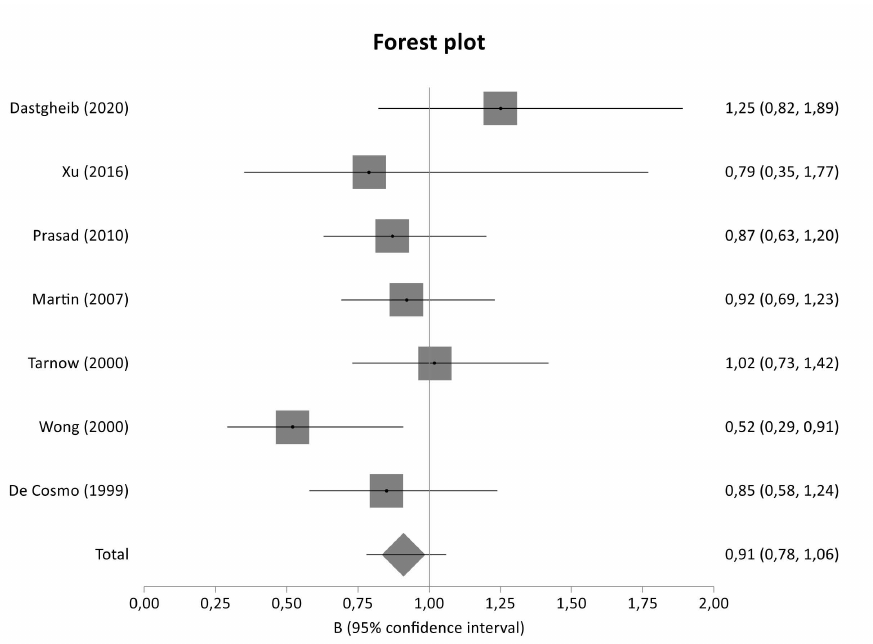
Figure 2. Forest plot of SERPINE1 4G/5G variant between diseased controls versus cases in main meta-analysis.